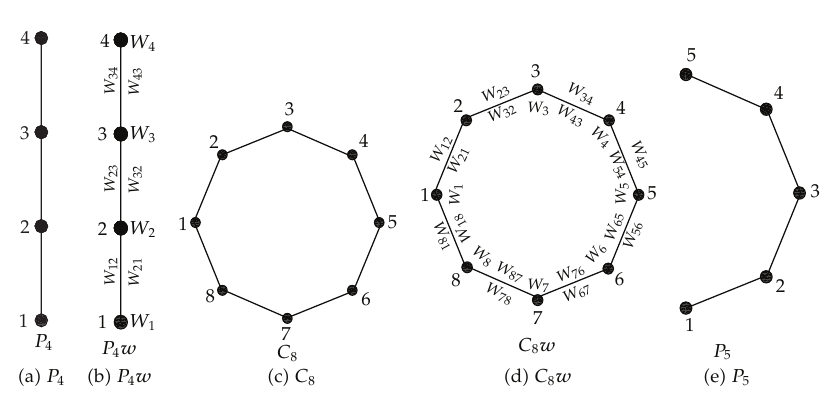
Figure 1: Examples of simple and weighted